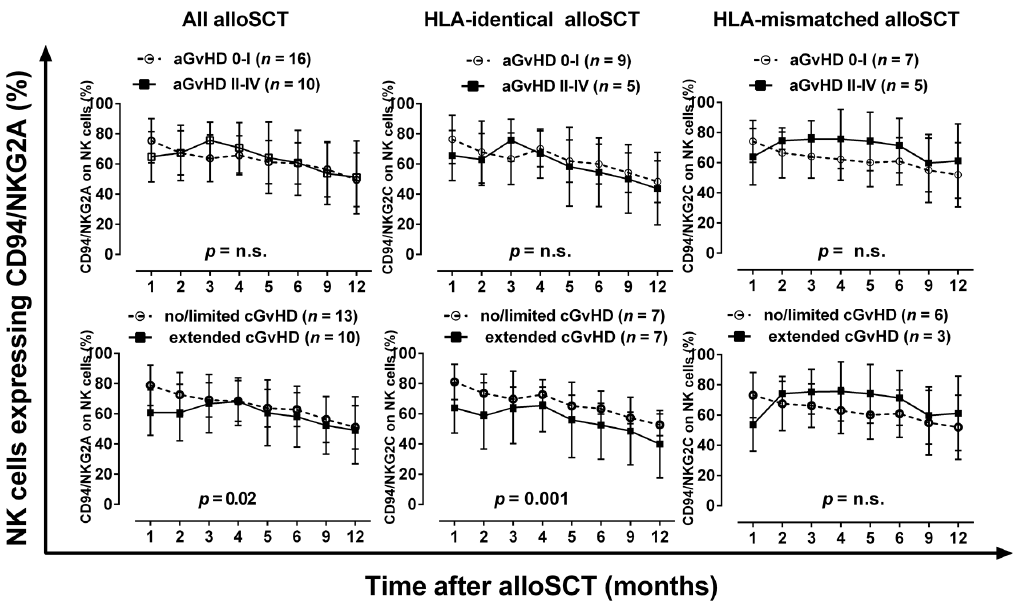
Figure 2. The proportions of NK cells expressing CD94/NKG2A during the course of the first year after alloSCT in relation to the occurrence of severe acute and chronic GvHD in patients receiving an HLA-matched or HLA-mismatched graft. Two-way ANOVA was used for statistical analysis.